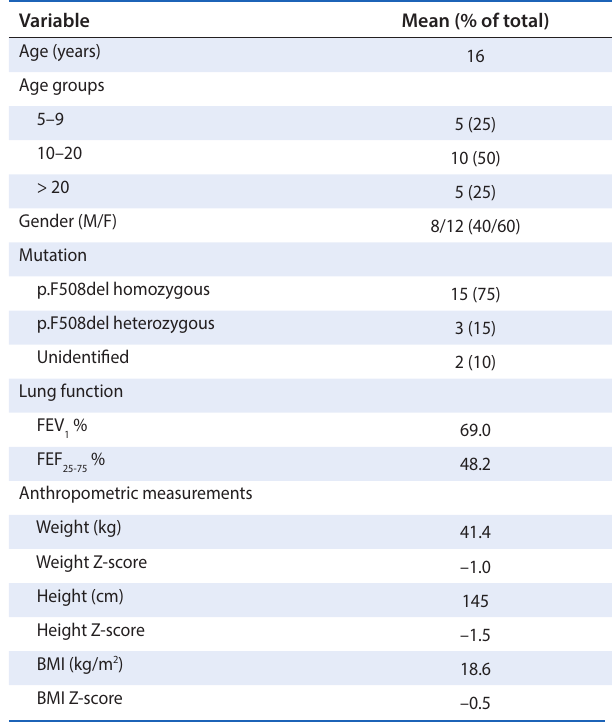
Table 1: Demographic data for study population at entry ( n =